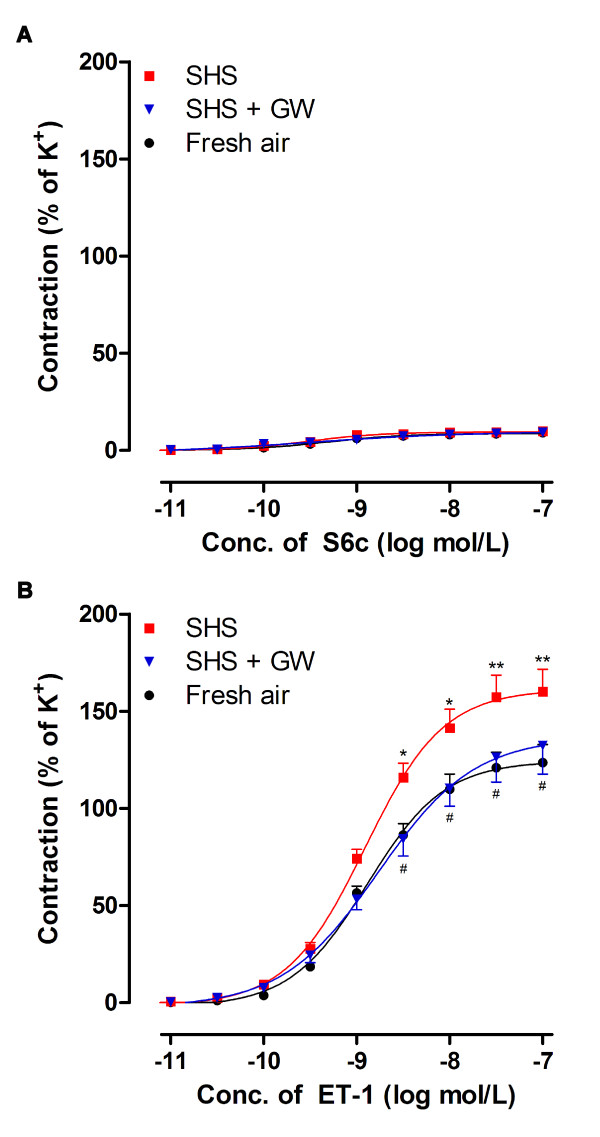
Contractile responses induced by S6c (A) and ET-1 (B) in rat cerebral arteries. The cerebral arteries were isolated from groups of fresh air, SHS and SHS treatment with GW5074. Contractions were induced by cumulative application of S6c or ET-1 (n = 8-10). *P < 0.05, **P < 0.01 versus fresh air group, #P < 0.05 versus SHS group; SHS, secondhand smoke exposure; GW, GW5074 (0.5 mg/kg).